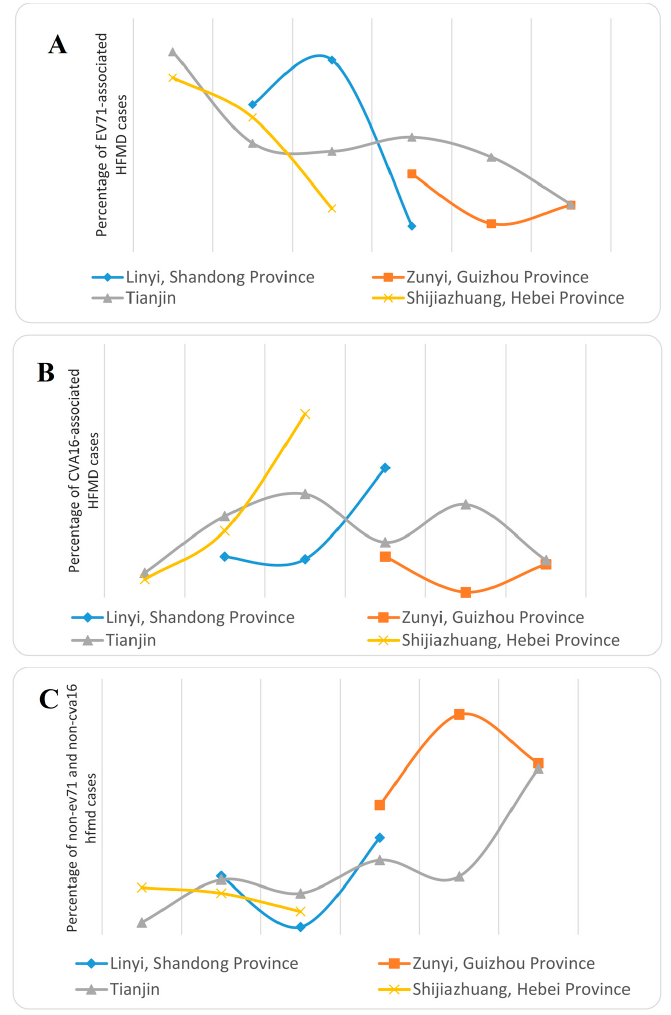
Figure 2. ( A ) Percentage of EV71-associated HFMD cases in different years; ( B ) Percentage of CVA16-associated HFMD cases in different years; ( C ) Percentage of non-EV71 and non-CVA116 HFMD cases in different